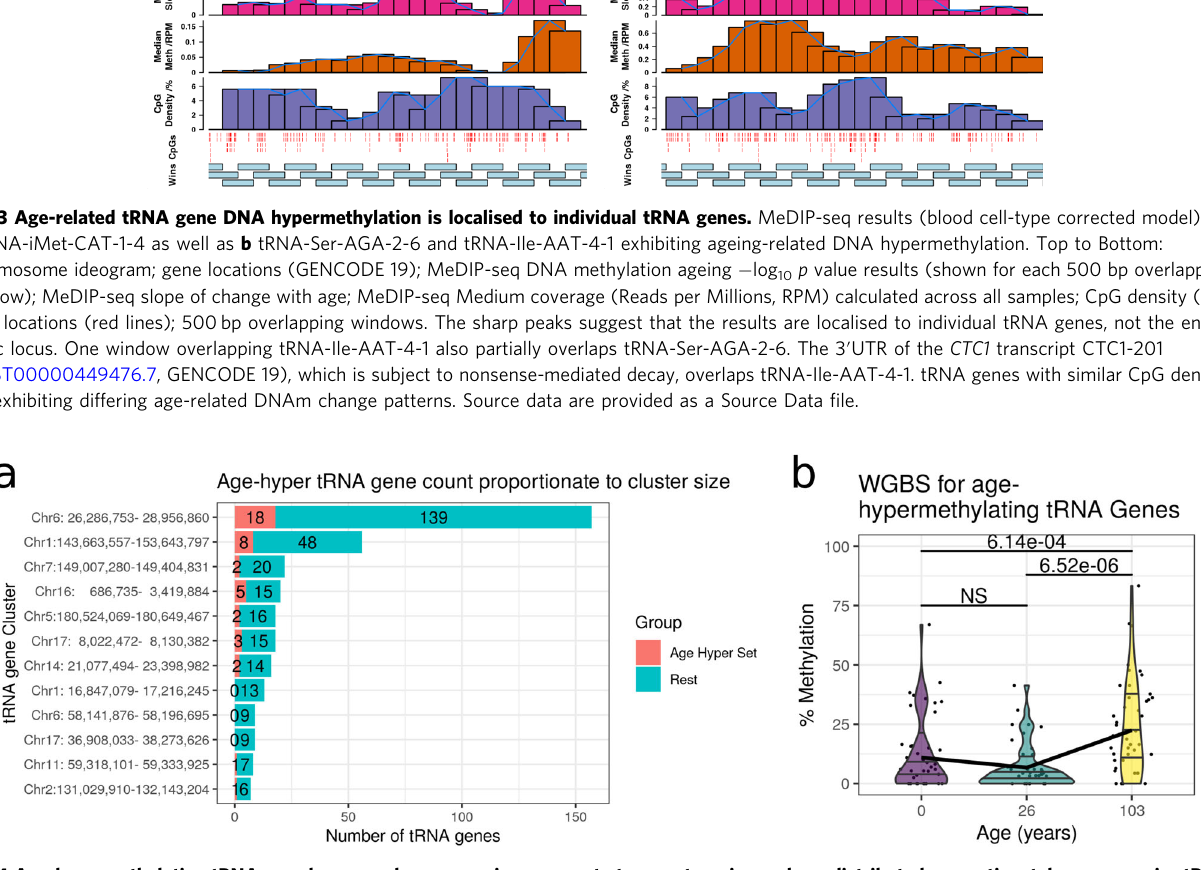
Fig. 4 Age-hypermethylating tRNAs can be seen when comparing a neonate to a centenarian and are distributed proportionately across major tRNA gene clusters. a No signi fi cant clusters of ageing-related tRNA. Proportion of non-blood cell corrected ageing-related study-wide signi fi cant tRNAs (42/44, red) within tRNA clusters (tRNAs within 5Mb with>5 tRNA genes/Mb). b Covered study-wide signi fi cant tRNA genes ( n = 14/16) are more methylated in a centenarian than in a neonate or an adult (26 years) in whole-genome bisul fi te sequencing (WGBS) data from Heyn et al. 50 . Each point represents individual CpG methylation levels within a tRNA gene. The horizontal lines in the violin plots represent the 25%, 50% and 75% quantiles. NS not signi fi cant. Source data are provided as a Source Data fi le.